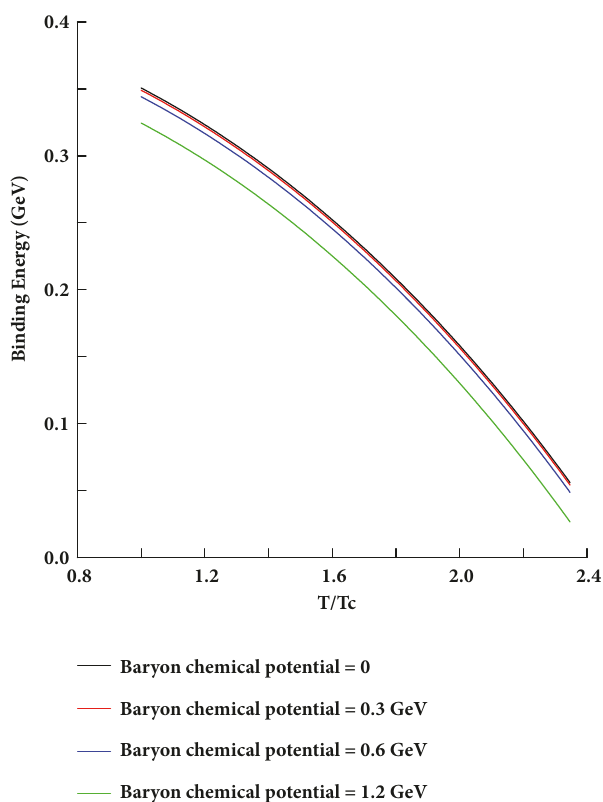
Figure 5: The binding energy of 1S charmonium is plotted in temperature at 𝜉 = 0.3 and 𝑁 = 3 for different values of baryonic chemical potential.